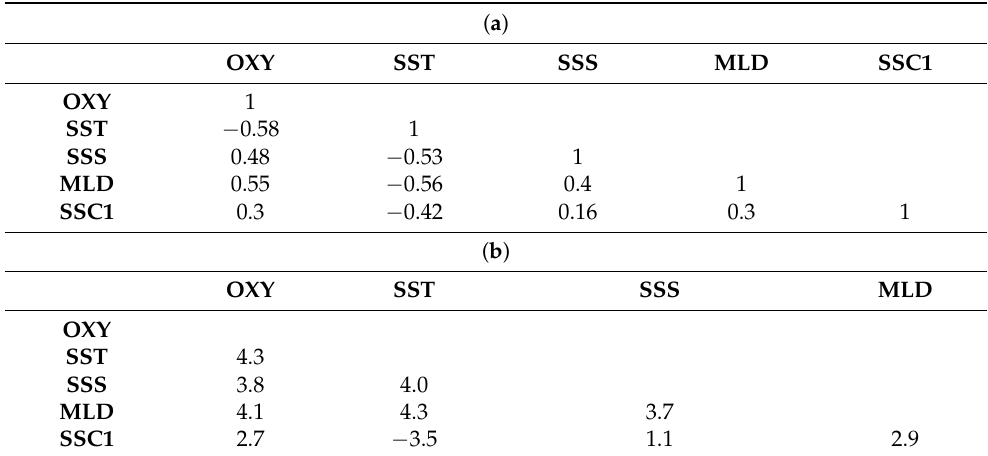
Table 4. ( a ) Multicollinearity test results for parameters selected for the immature albacore tuna model based on Pearson correlation analysis value. ( b ) Multicollinearity test results for parameters selected for the immature albacore tuna model based on VIF value.